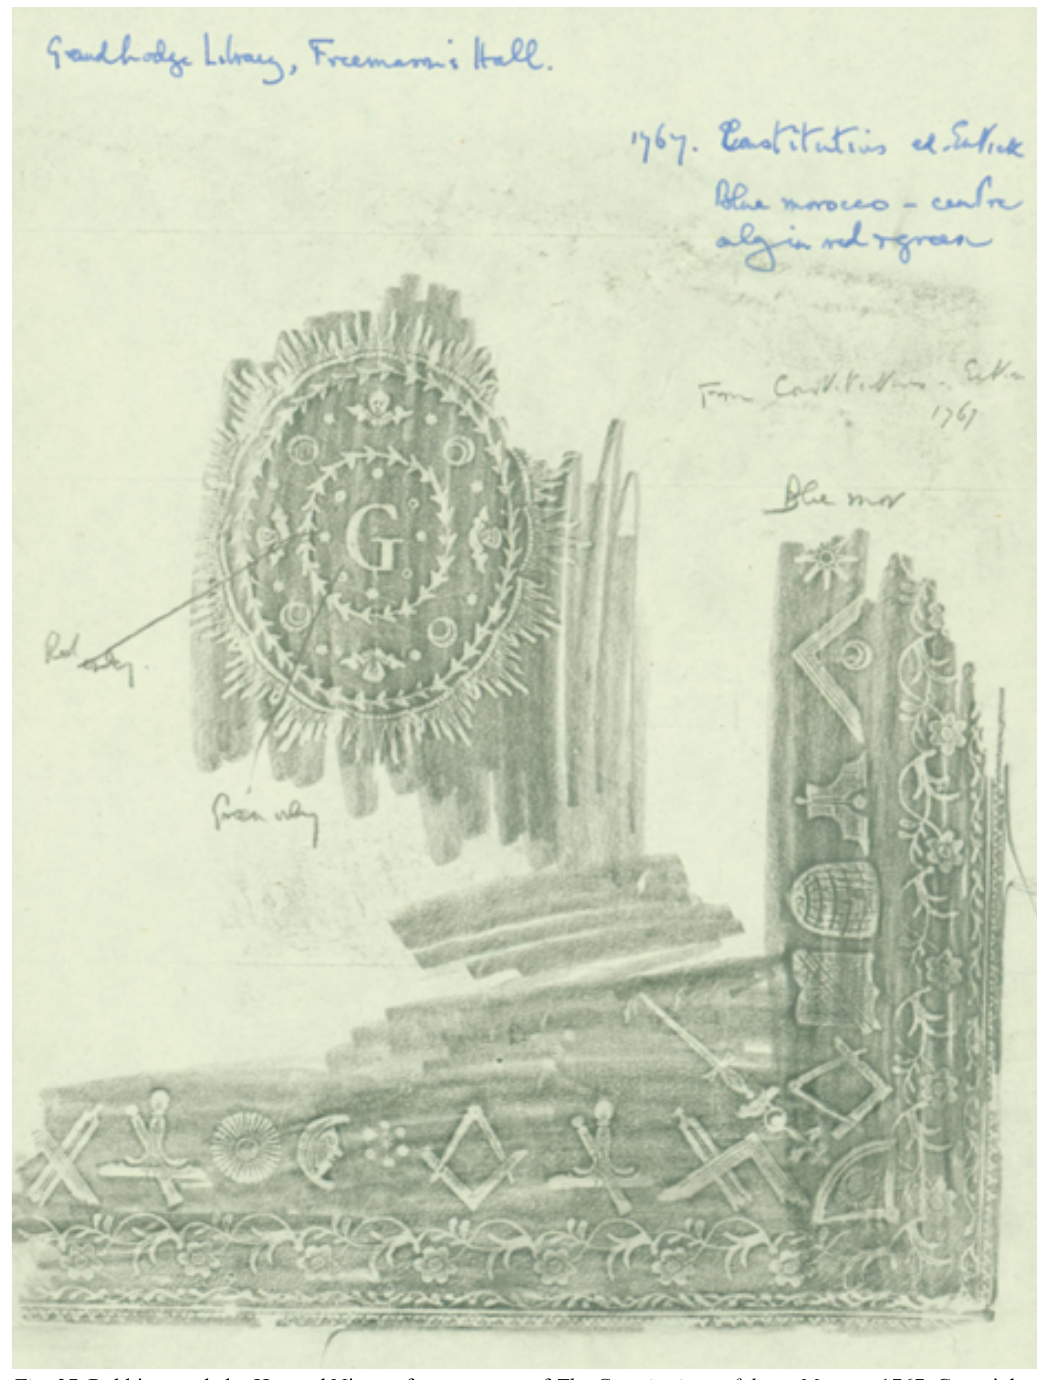
Fig. 27. Rubbing made by Howard Nixon of upper cover of The Constitutions of the ... Masons , 1767. Copyright and reproduced by permission of the Museum of Freemasonry, London.